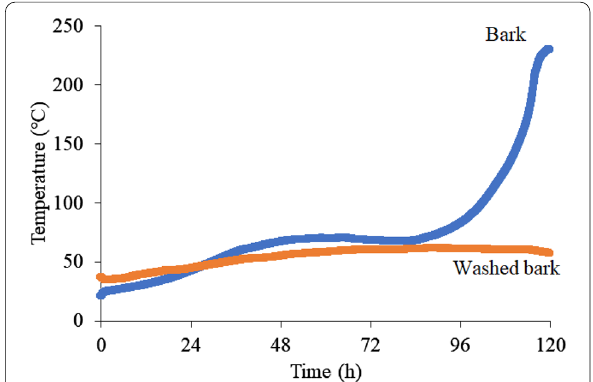
Fig. 8 Self-heating of raw and washed bark chips